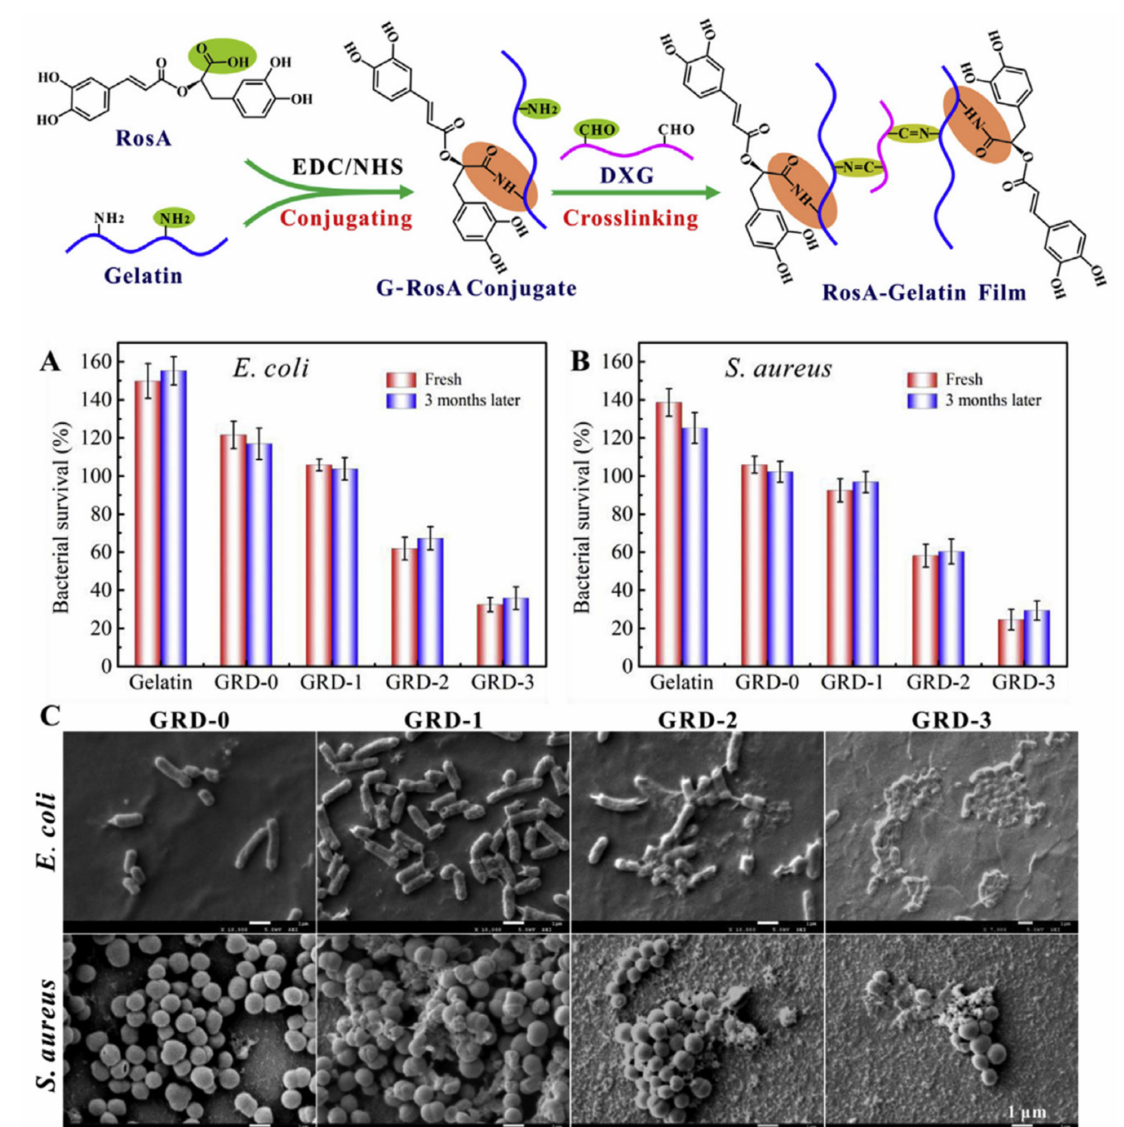
Figure 7. Scheme of preparation of RA-gelatin film. Survival rates of E. coli ( A ) and S. aureus ( B ) after treating with newly prepared (red histogram) and 3 months stored (blue histogram) gelatin-based edible films for 24 h at 37 ◦ C. ( C ) SEM images of E. coli and S. aureus after treating with gelatin-based edible films for 24 h at 37 ◦ C (adapted from Ge et al. [115], copyright 2018